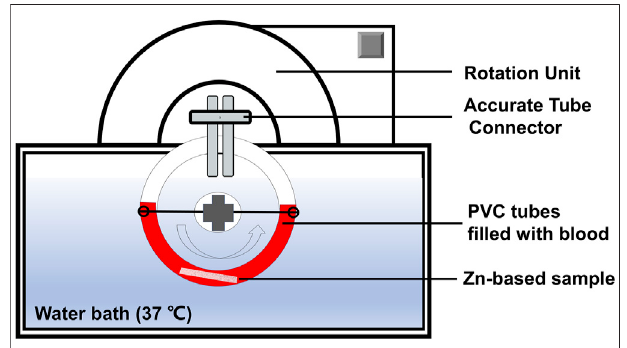
FIGURE 1 | Schematic representation showing the modi fi ed Chandler- Loop